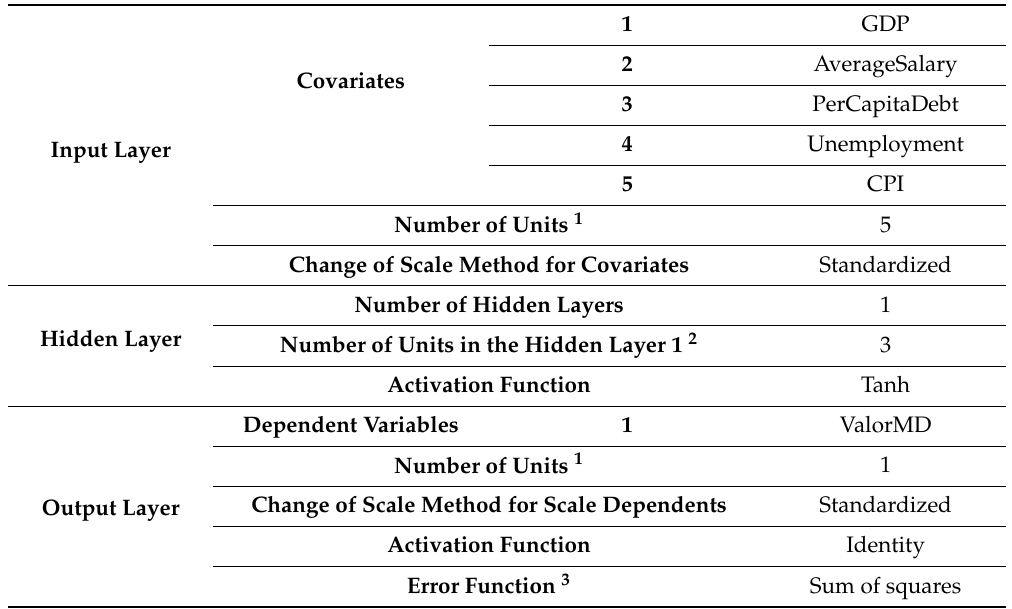
Table 5. Description of the network